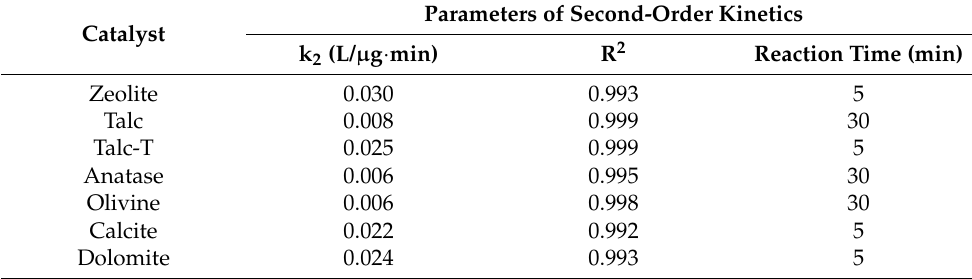
Table 3. Values of second-order kinetic parameters for p-CBA degradation in ozonation systems, when using efficient materials as catalysts. Experimental conditions: initial p-CBA